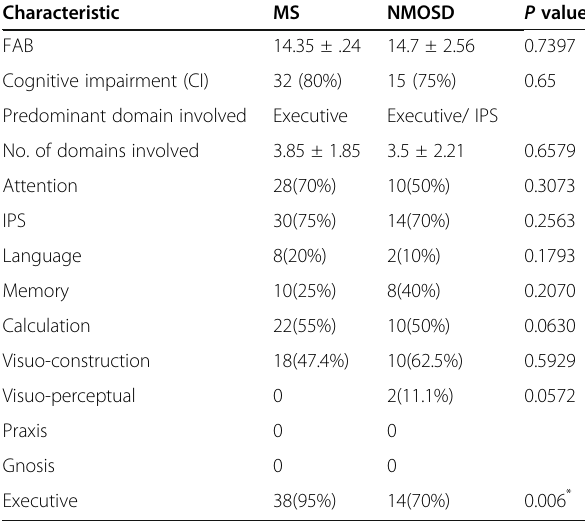
Table 3 Cognitive performance of NMOSD vs MS patients